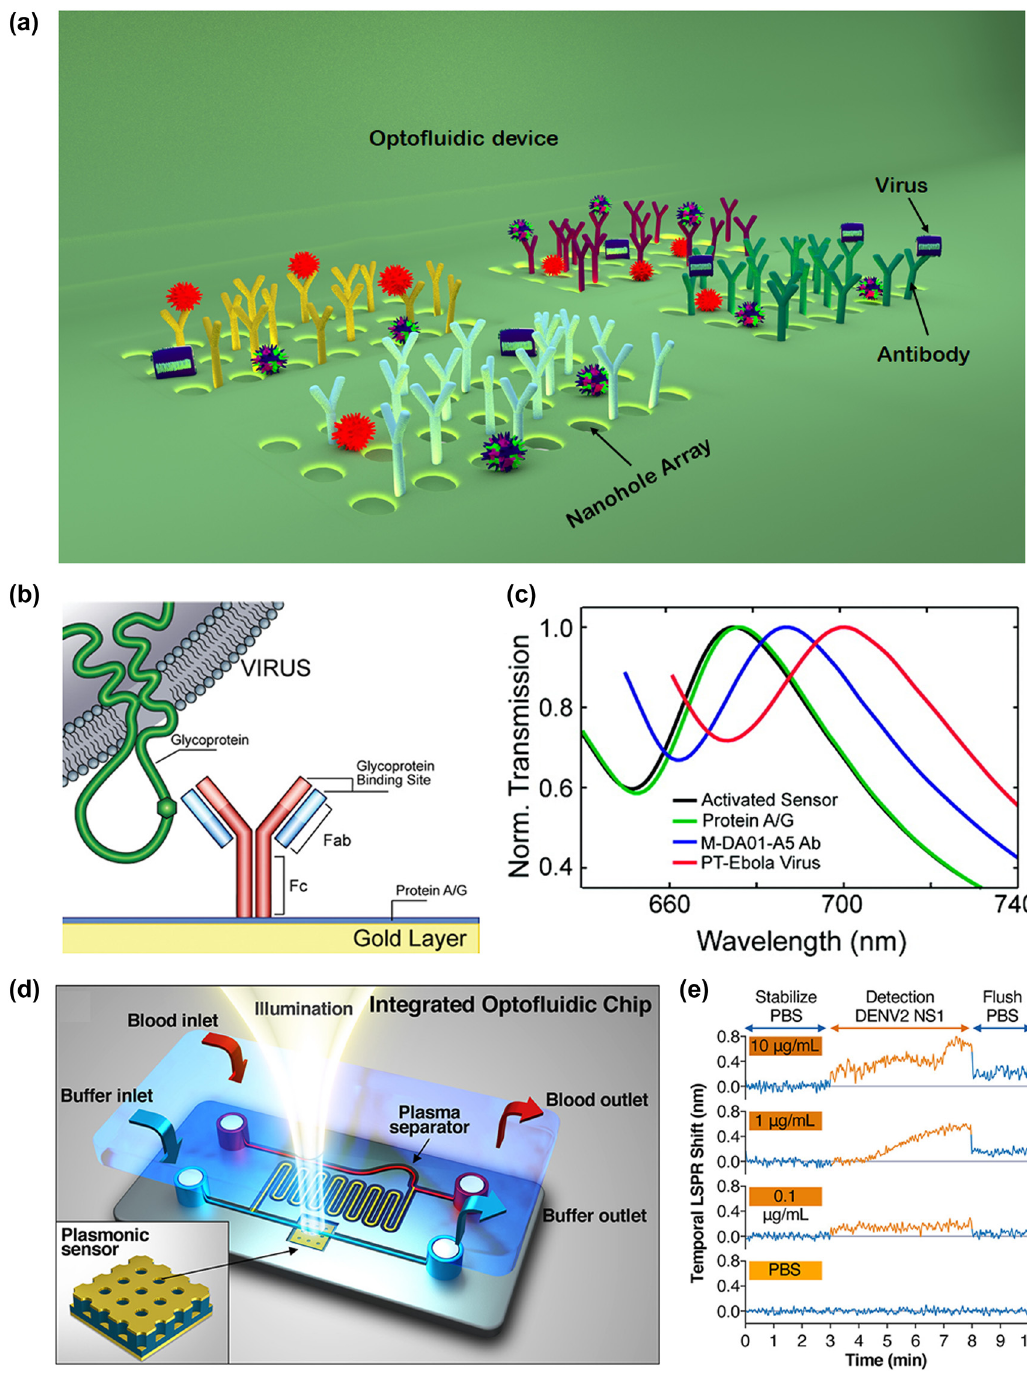
Figure 2: Illustration of the optofluidic nano-plasmonic technique for virus detection. (a) Three-dimensional illustration of the detection scheme using optofluidic nano-plasmonic biosensors based on resonance transmissions due to extraordinary light transmission effect. (b) Illustration of the immunosensor surface functionalization. Antiviral immunoglobulins are attached from their F through a protein A/G layer. Adapted with permission from ref. [35]. Copyright [2010] American Chemical Society. (c) Binding results in large effective refractive index increase leading to a strong red shift of the plasmonic resonance. Adapted with permission from ref. [35]. Copyright [2010] American Chemical Society. (d) Integrated optofluidic device for Dengue virus detection based on nanoimprinted plasmonic array. Adapted with permission from ref. [42]. Copyright [2021] American Chemical Society. (e) Temporal evolution of the LSPR shift for three DENV2-NS1 protein concentrations (0.1, 1, and 10 μ g/mL) in PBS and a control sample (no proteins in PBS). Adapted with permission from ref. [42]. Copyright [2021] American Chemical